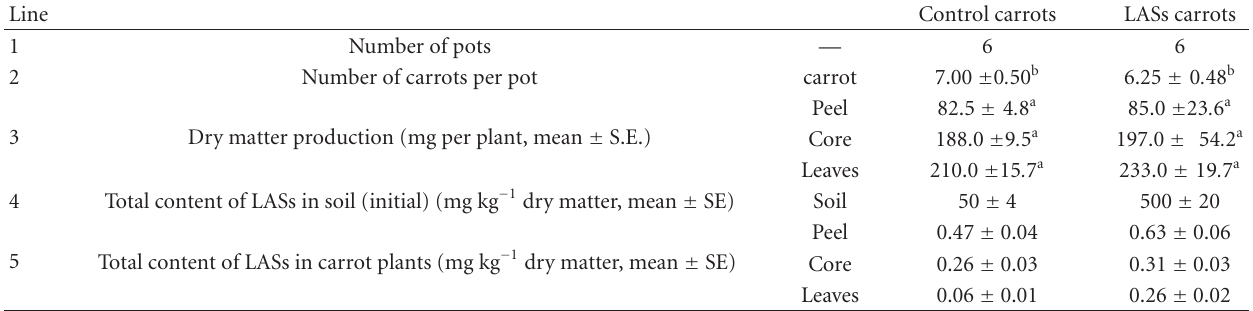
Table 1: Number of carrots per pot; dry matter production; LASs concentration in soil, and LASs concentration in carrots. Mean values of four replications followed by the same letter in a column are not significantly di ff erent at P < . 05, ± SE, standard error in variance analysis.